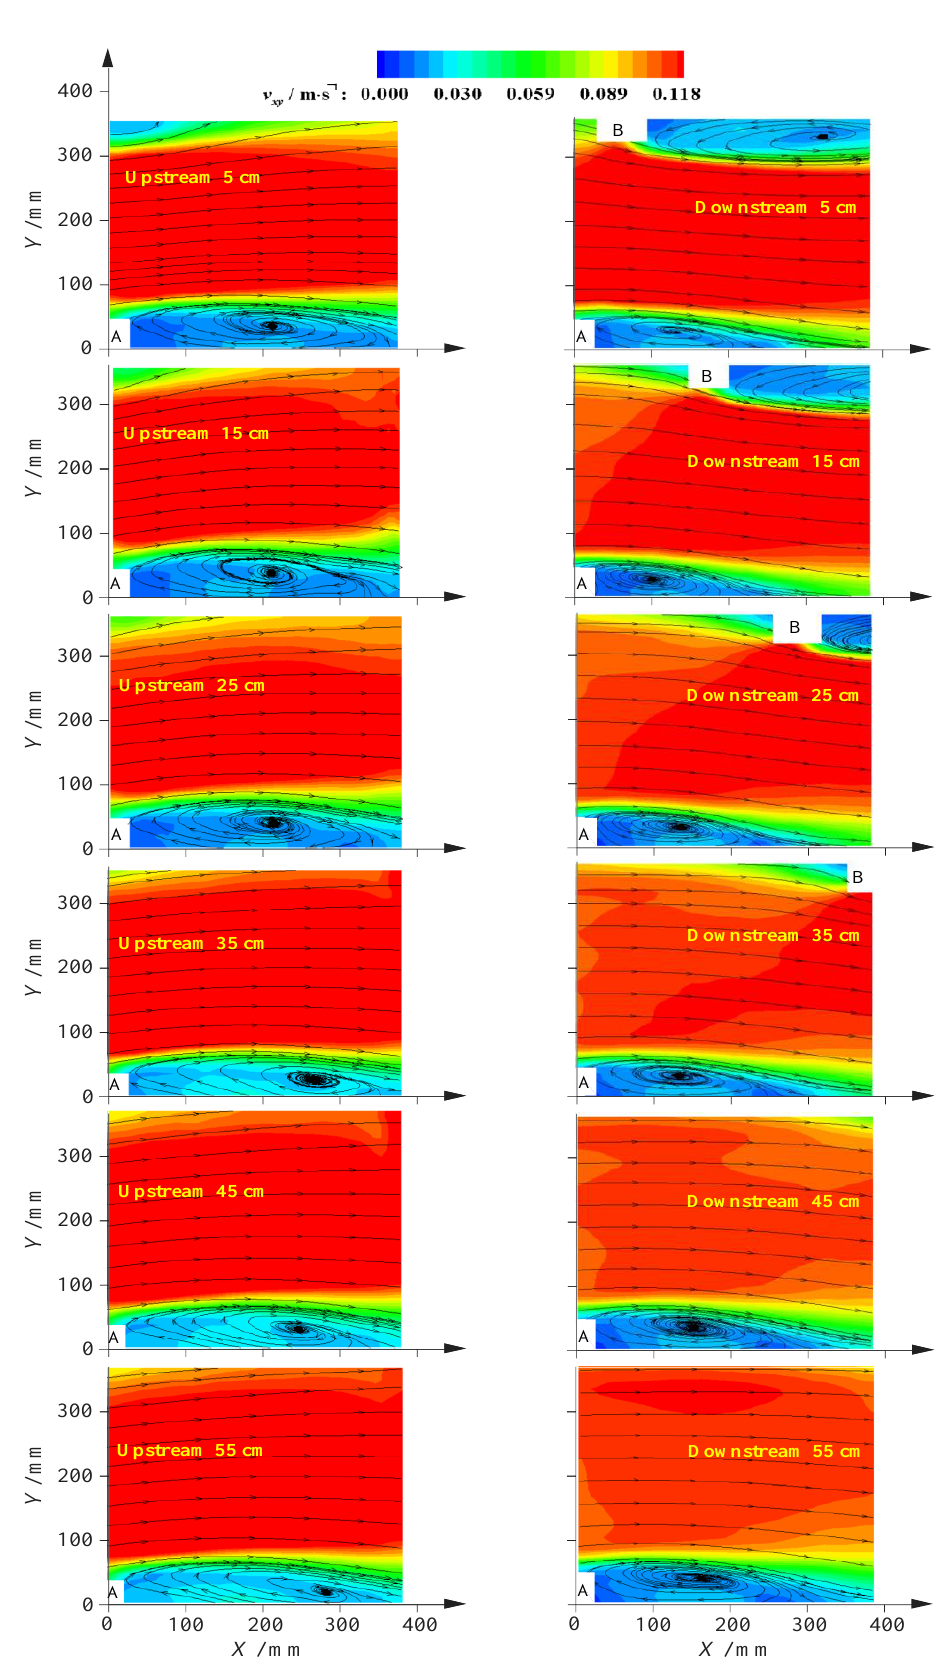
Figure 6. Time-averaged horizontal streamlines and velocity distribution of alternate groins configuration with Groin B at the opposite bank at 5 to 55 cm upstream (left column) and downstream (right column) from Groin A.